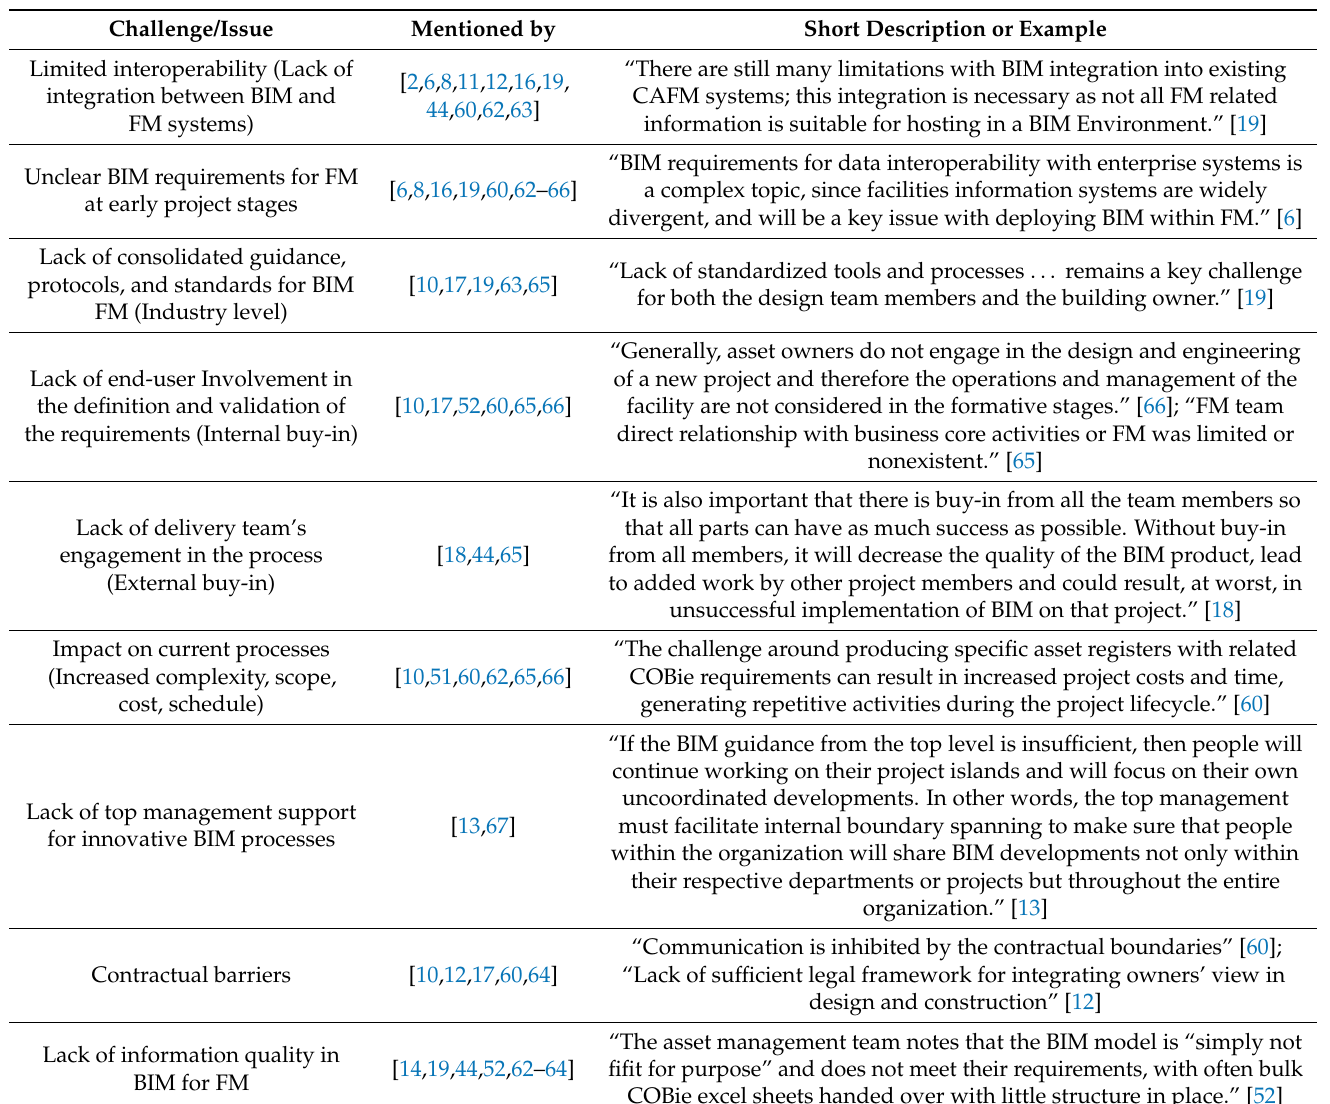
Table 2 categorizes some of the main challenges: Table 2. Summary of challenges described in the